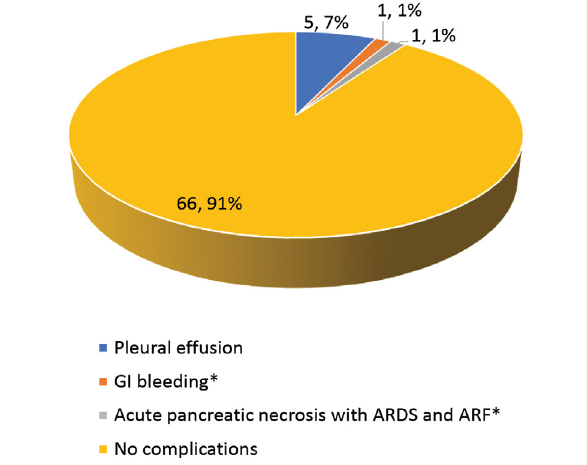
Figure 1. Complications of acute biliary